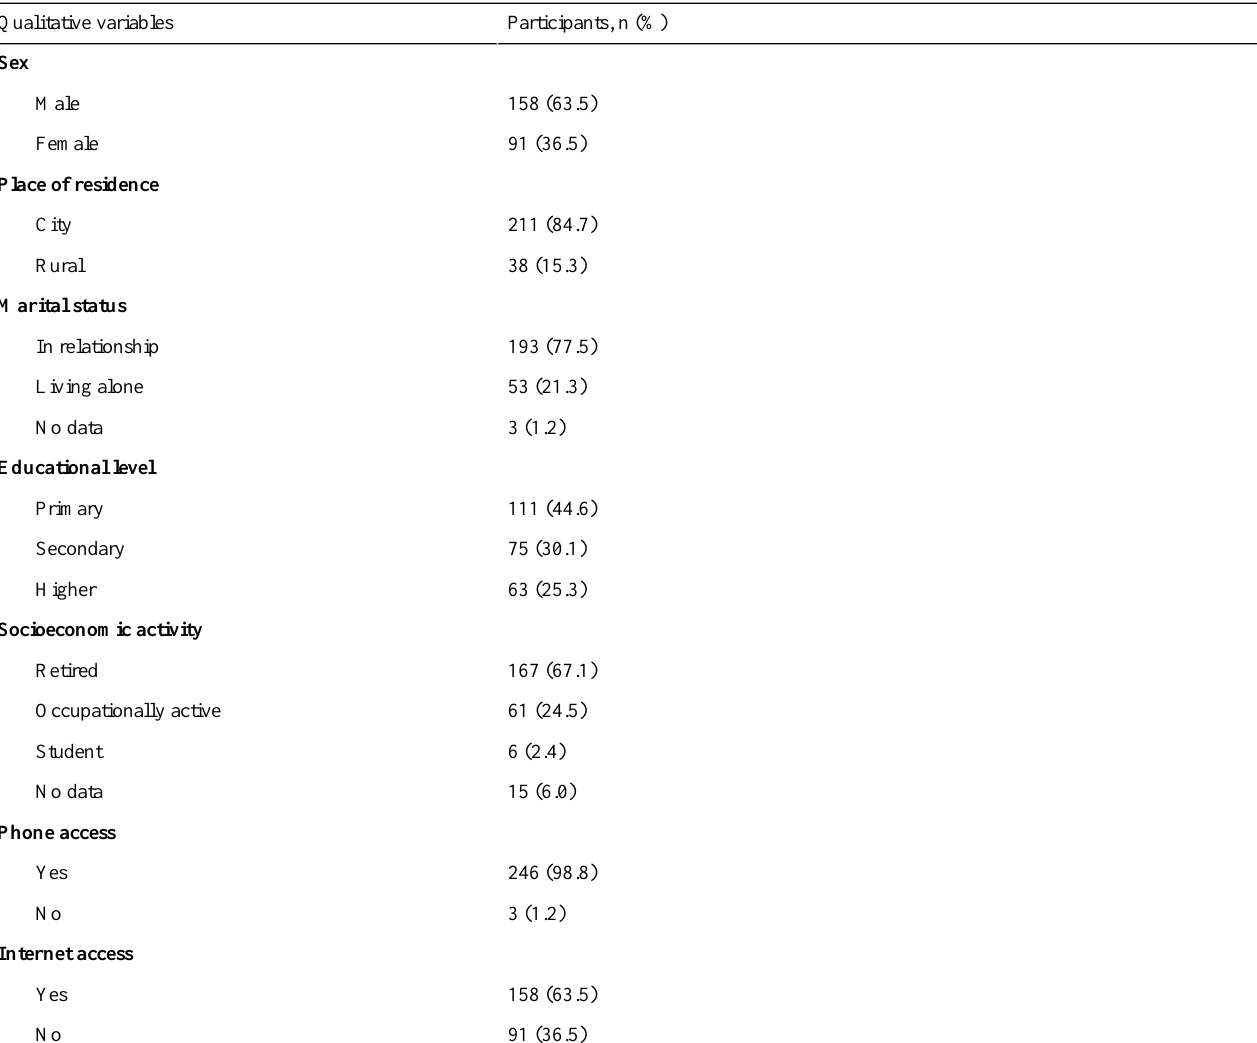
Table 1. Baseline socioeconomic